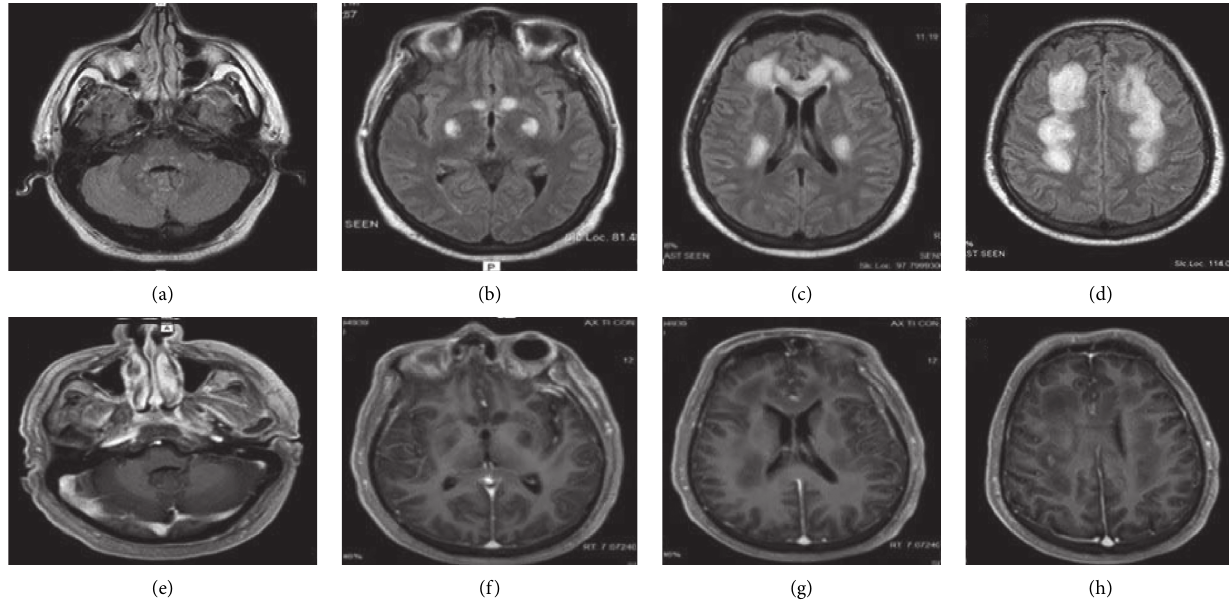
Figure 1: FLAIR brain MRI showing hyperintensity involving peduncles and middle cerebellar peduncles (a). Head of the caudate nucleus and both globus pallidus (b). Corpus callosum and corona radiata (c, d). Gadolinium T1 sequence (e–h) showing focal pathological enhancement in the right parietal lobe (h).